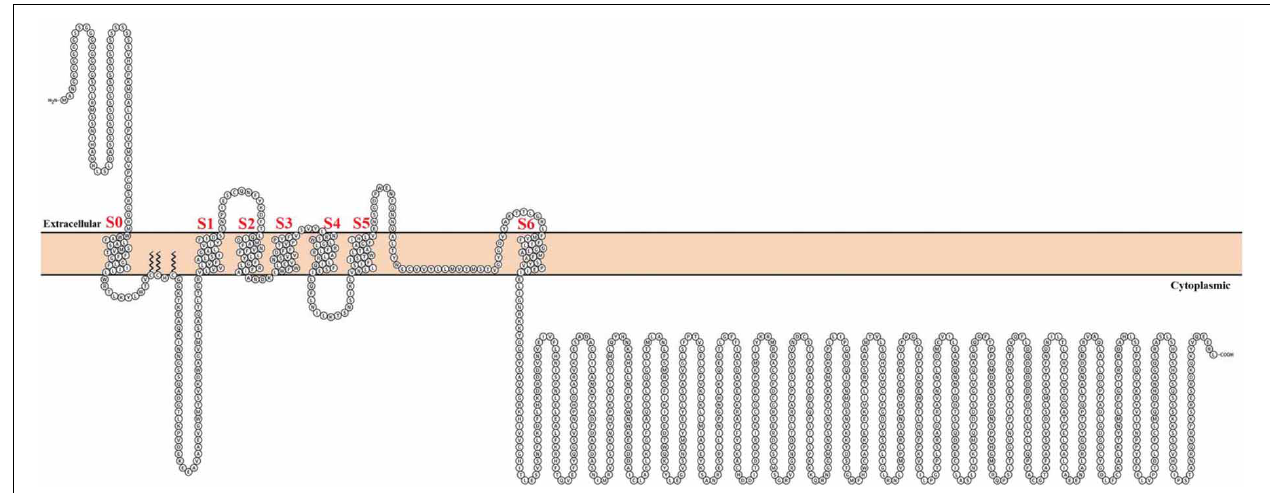
FIGURE 1 | Topological representation of the human Calcium-activated potassium channel α subunit. Using Protter visualizator (Omasits et al., 2014), UniProt protein accession: Q12791.